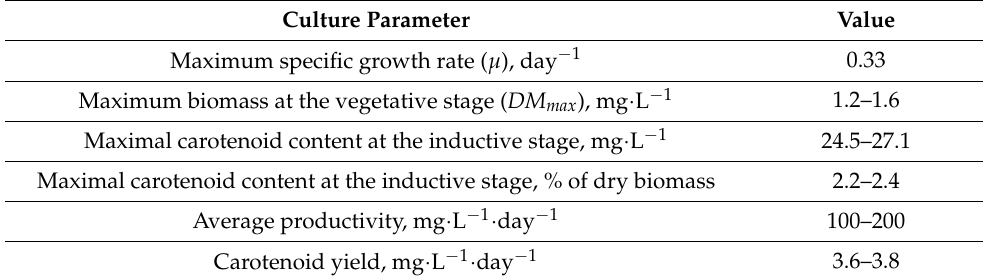
Table 1. Main parameters of the Bracteacoccus aggregatus BM5/15 (IPPAS C-2045) growth and carotenoid accumulation in the bubble-column